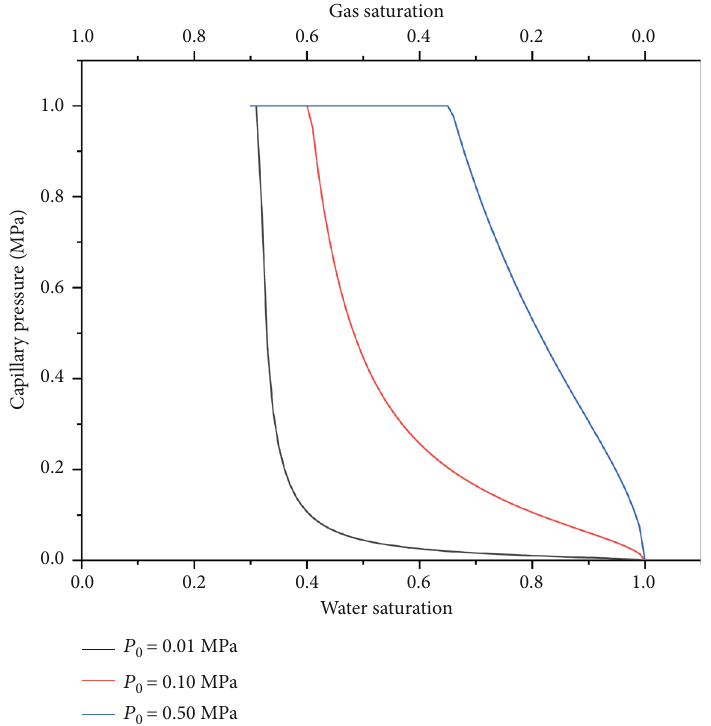
Figure 15: Relationship between capillary pressure and water or gas saturation in di ff erent gas entry pressure